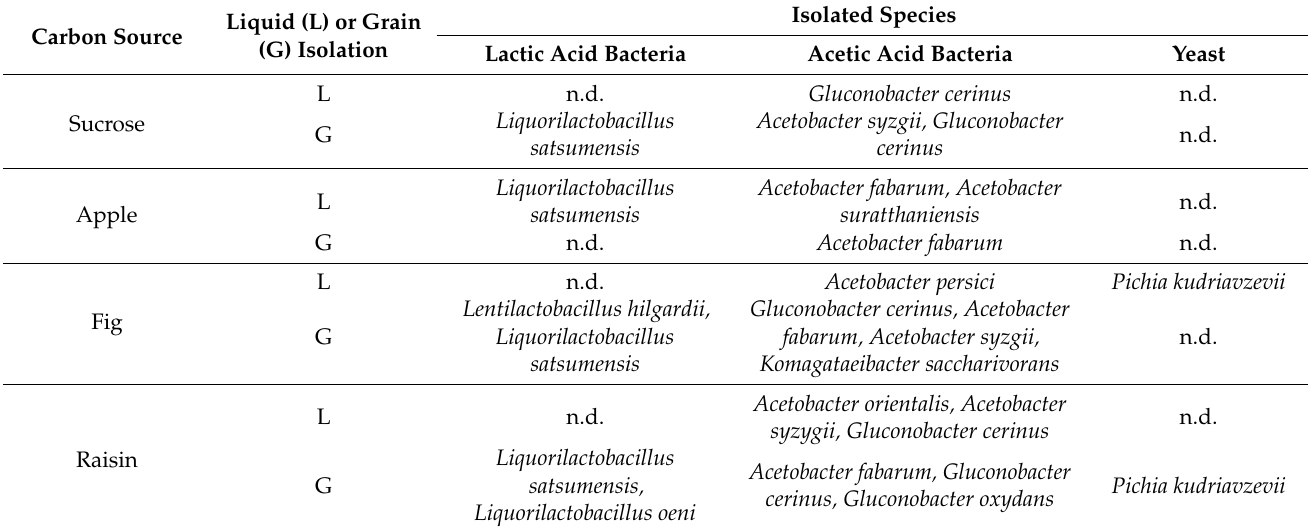
Table 2. Bacteria and yeast species isolated from fruit water kefirs fermented with HKUK